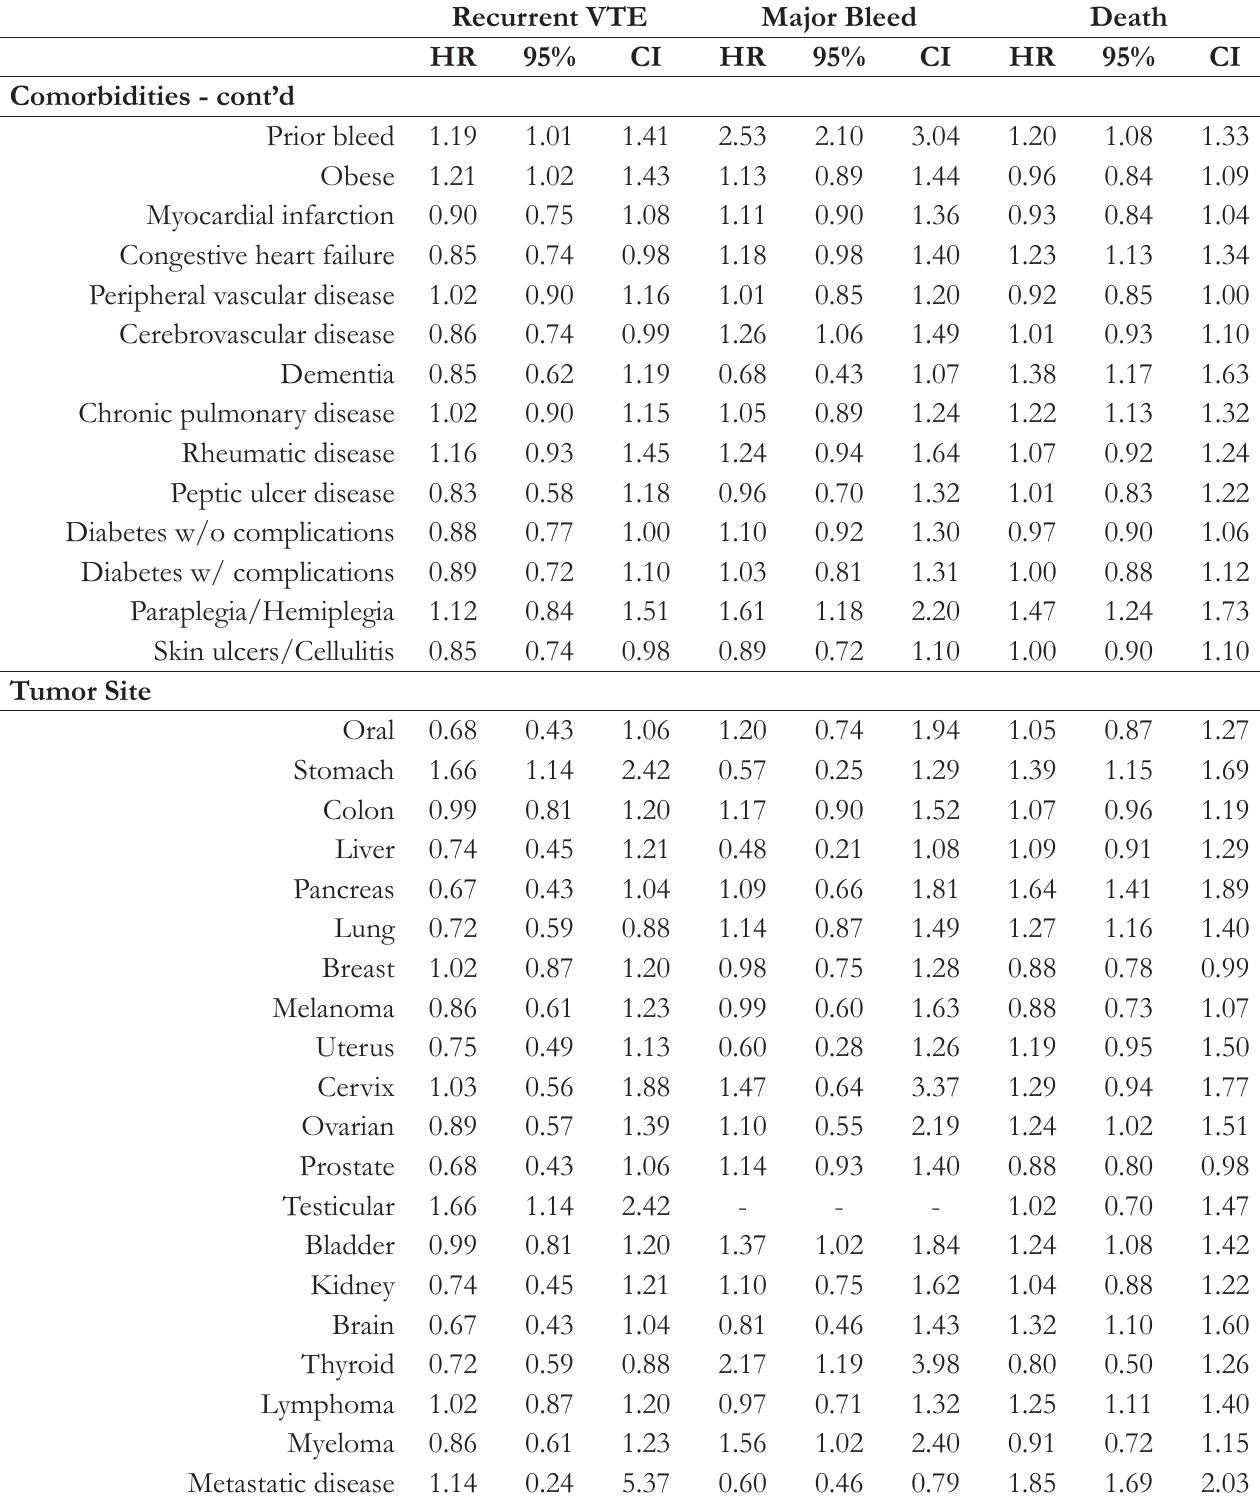
Table 3. Event-specific HRs and 95% CIs from IPTW Competing Risks Analysis -